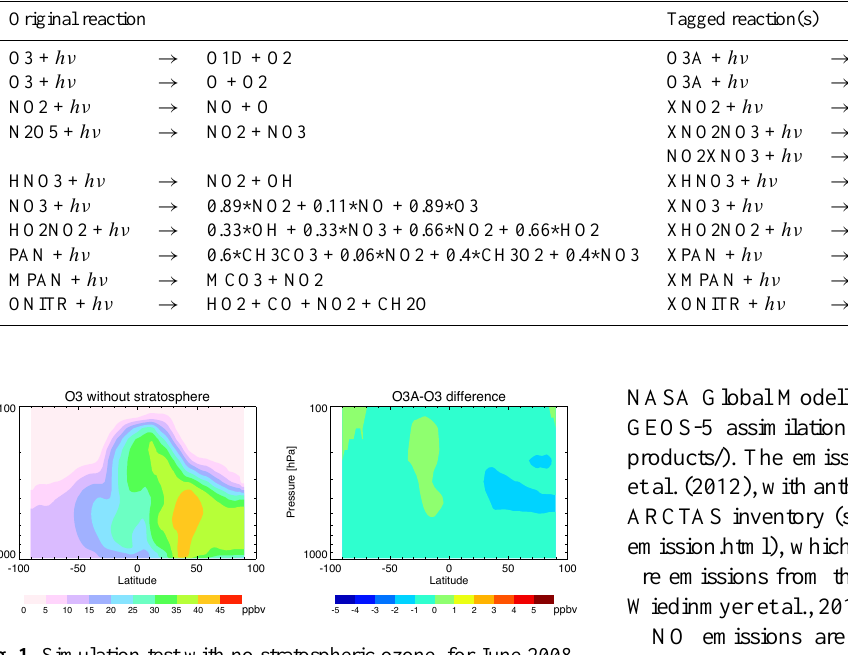
Fig. 1. Simulation test with no stratospheric ozone, for June 2008. Left: Base ozone, without stratospheric input; Right: difference be- tween tagged ozone and base